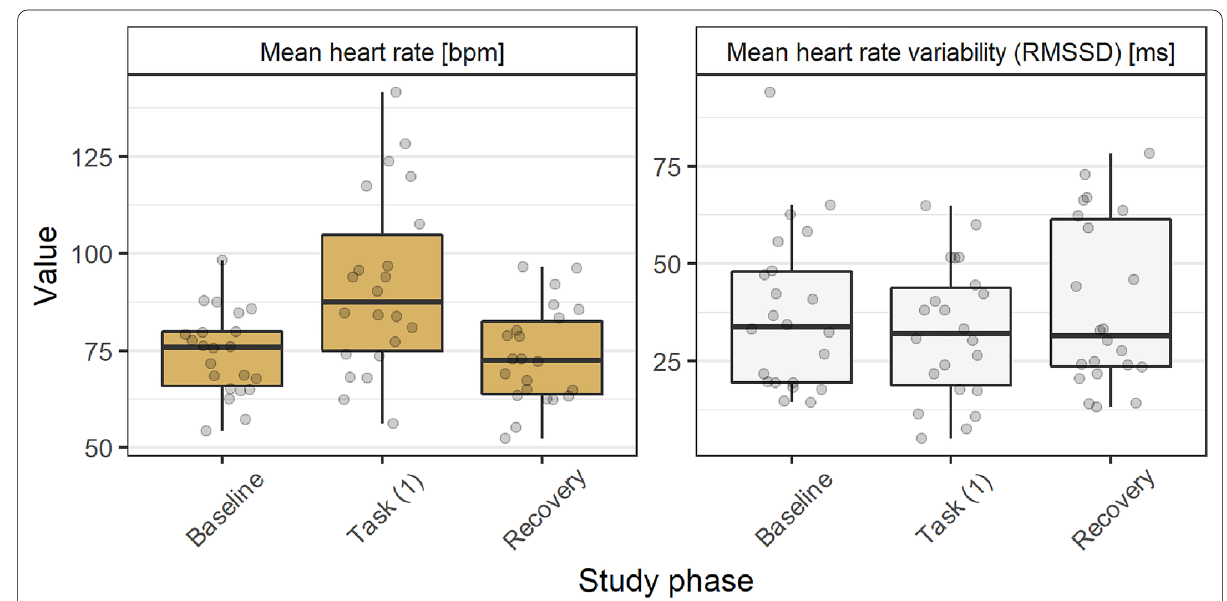
Fig. 7 Cardiovascular activity throughout study